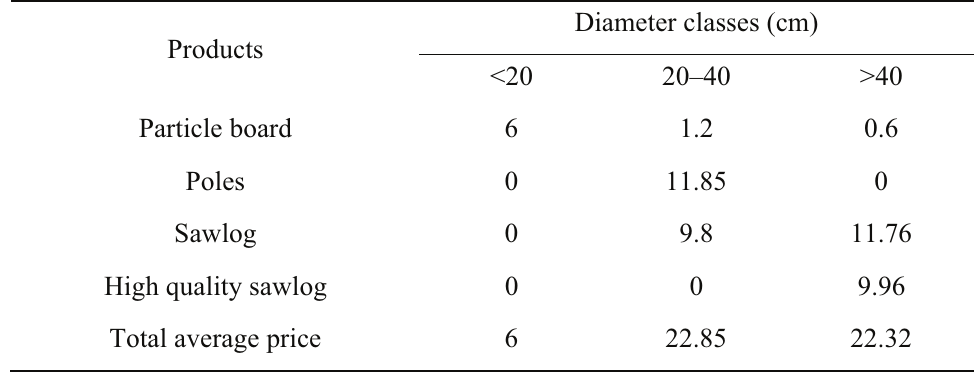
(cid:28) 3 (cid:28) 3 D ); and Quality III: (cid:28) 2 (cid:28) 1 D ) (stumpage prices v in euro stem and